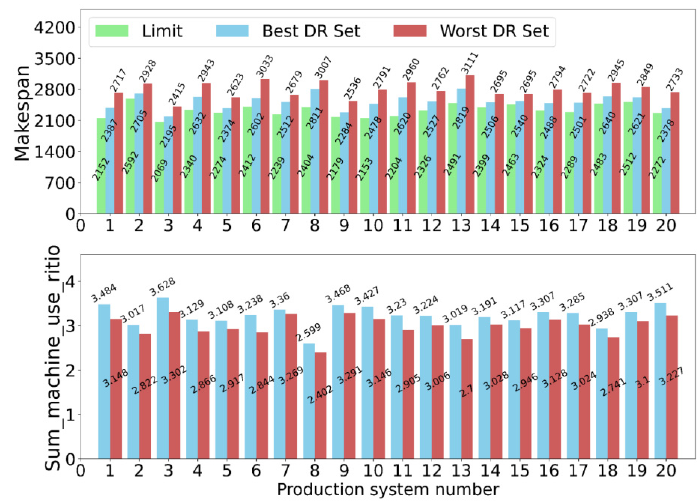
Figure 7. Low job heterogeneity and a low manufacturing system load rate.